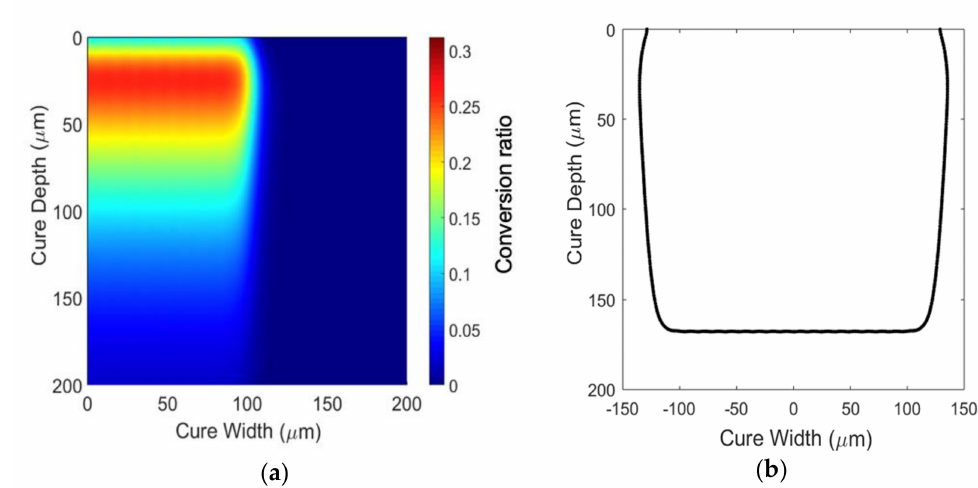
Figure A3. Conversion contour layer profile extraction: ( a ) Conversion contour for layer profile; ( b ) Extracted shape of the cured profile based on the 4% (0.04) cutoff conversion ratio contour.